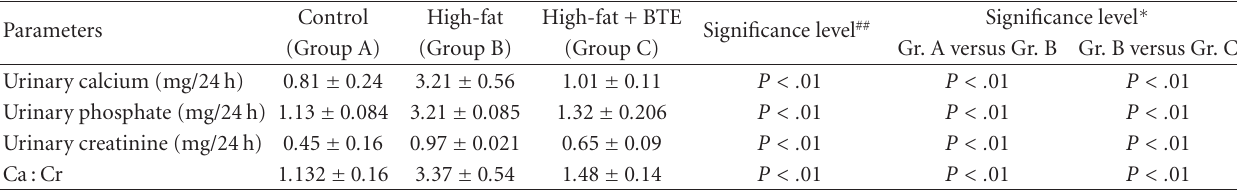
Table 1: Urinary excretion of calcium, phosphate, creatinine, and calcium : creatinine (Ca:Cr) ratio in control (Group A), HFD (Group B) and HFD + BTE (Group C) supplemented groups of rats.